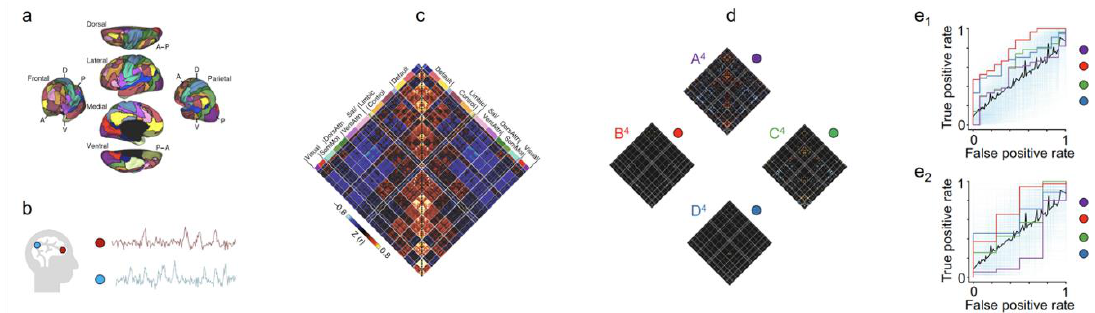
Figure 2. Using predictive models to uncover distinctive brain states and areas to diagnose psychosis. ( a ) The functional network organization of the human cerebral cortex is revealed through intrinsic functional connectivity. Colours reflect regions estimated to be within the same network determined based on the 17-network solution from Yeo et al. [17]. The map is displayed for multiple views of the left hemisphere in Caret PALS space [18]. ( b ) A schematic representation of time courses obtained from two brain regions. ( c ) Correlation matrices (a measurement of functional connectivity) are computed from time courses across regions. Values reflect z-transformed Pearson correlations between every region and every other region. DorsAttn indicates dorsal attention, Sal salience, SomMot somatomotor, and VentAttn ventral attention. ( d ) Brain states exhibit hierarchical features across distributed networks. Correlation matrices for four states (arranged using k-means clustering) are shown for each region. ( e ) Specific brain states are predictive of distinct clinical symptoms in novel individuals. ( e 1 ) State B 4 uniquely predicted the presence of active psychosis in patients with psychotic illness. Results from a leave-one-subject-out cross-validation elastic-net logistic regression analysis comparing predicted and observed psychotic symptoms ( n = 91). The displayed area under the receiver-operating characteristic curve (AUC) reflects the scalar probability measure for each individual, predicting the likelihood of active psychotic symptoms. The blue semi-transparent lines reflect 1000 ROC curves from 1000 permutation experiments. The black dashed line indicates the mean of these 1000 curves, approximating a null curve. The purple, red, green, and orange curves correspond to states A 4 , B 4 , C 4 , and D 4 , respectively. ( e 2 ) Connectivity models defined on training data predict the presence of active psychotic symptoms in an independent group of participants ( n = 31). The displayed AUC graph reflects the scalar probability measure, predicting the likelihood of active psychosis, defined using positive edges from the initial training set without further fitting or modification, in a held-out sample of